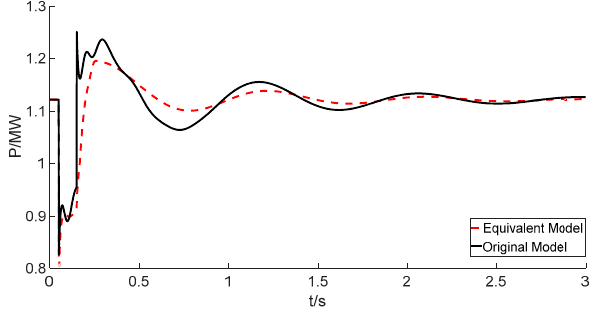
Figure 10. The active power response under single fault conditions. Table1. The parameters of the equivalent model.